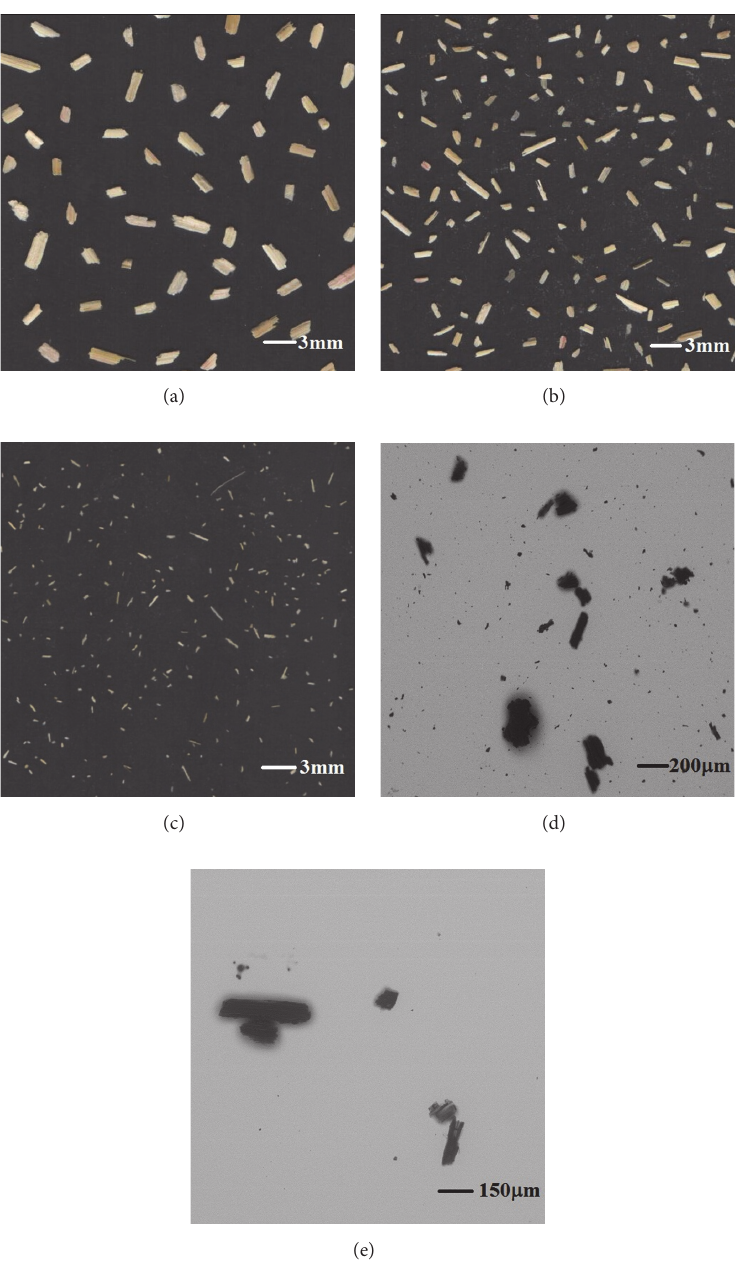
Figure 3: Sample images of ground wheat straw particles from five size ranges: (a) > 1000 𝜇 m, (b) 500–1000 𝜇 m, (c) 250–500 𝜇 m, (d) 75– 250 𝜇 m, and (e) < 75 𝜇